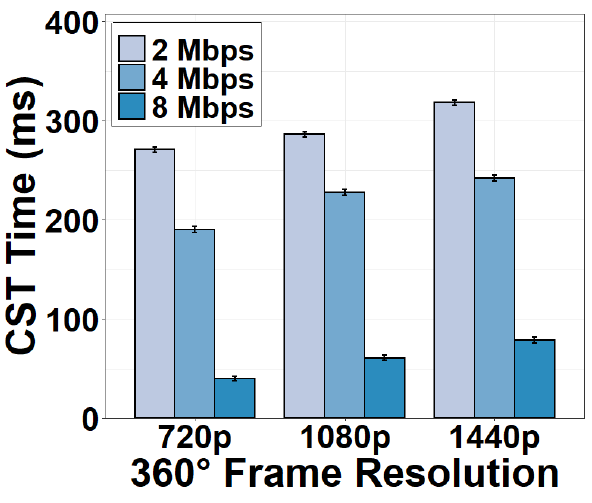
Figure 11. CST time versus upload bandwidth.